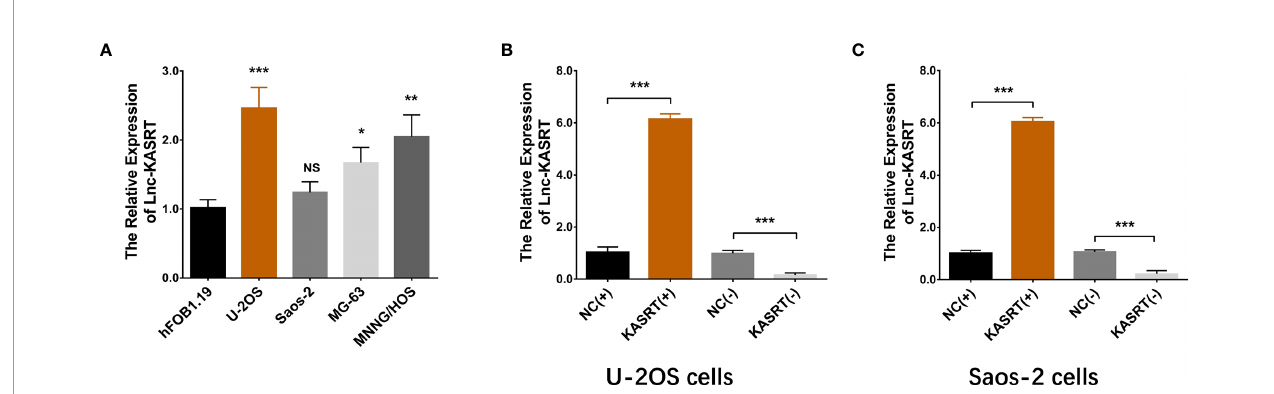
FIGURE 1 | Lnc-KASRT expression. Lnc-KASRT expression among osteosarcoma cell lines and a control cell line (A) ; Lnc-KASRT expression after transfection in both U-2OS (B) and Saos-2 cells (C) . *P < 0.05, **P < 0.01, ***P < 0.001, NS, Not signi fi cance (P >